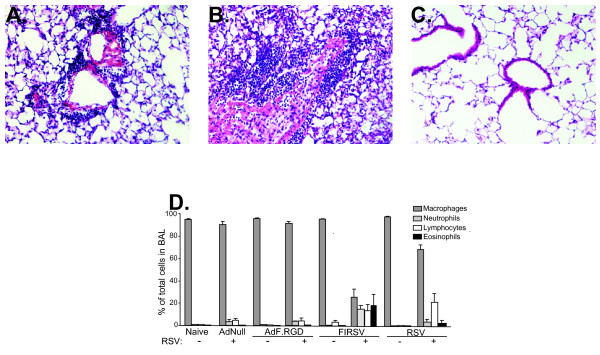
Absence of RSV-induced inflammatory responses in lung and BAL following immunization with AdF.RGD. BALB/c mice were immunized subcutaneously with AdNull, AdF.RGD (both at 1010 pu), formalin-inactivated RSV (FIRSV, 105 pfu) or intranasally with RSV (106 pfu). Five wk later the mice were challenged intranasally with RSV (106 pfu) and lungs were harvested after 6 days. A-C. Lung histology (H+E stain): A. RSV, B. FIRSV, C. AdF.RGD. D. Quantification of cells in BAL. Data for D are shown as mean ± SEM of duplicate measurements of n = 4 mice/group and represent one of two independent experiments.